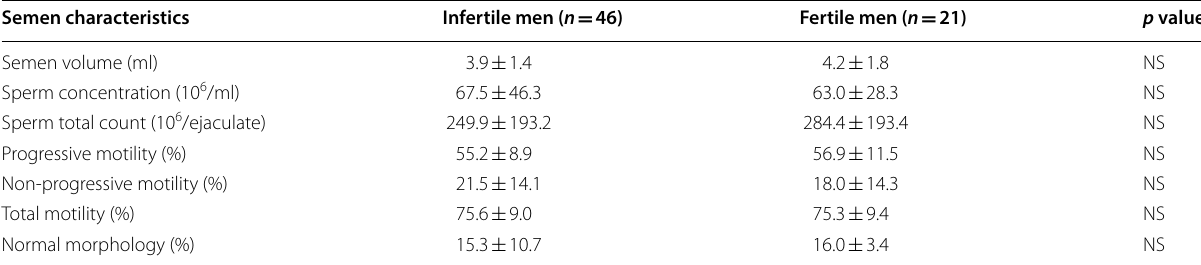
NS No significant difference ( p